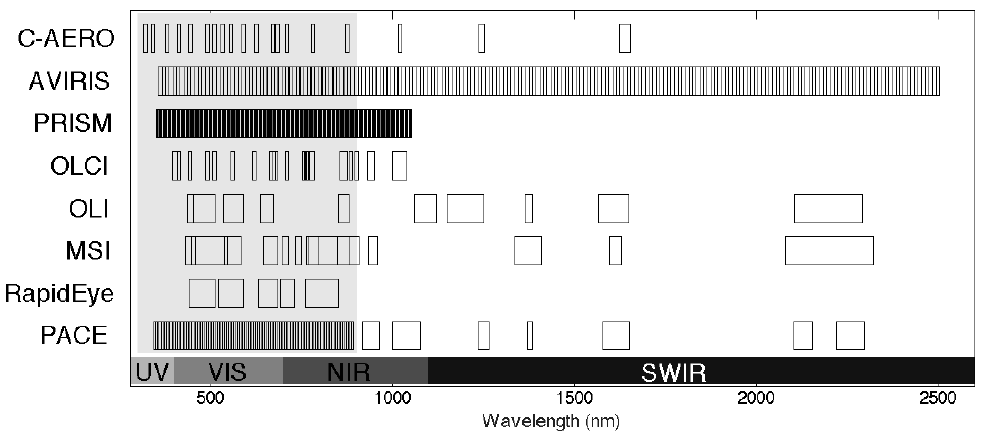
Figure 1. Airborne and satellite sensors considered for simulating H4 sensing, showing band placement and bandwidth. This analysis focuses primarily on the visible (VIS) and near-infrared (NIR) from 400–850 nm, while next-generation sensors such as PACE will extend into the ultraviolet (UV) and most sensors include short wave infrared (SWIR) for atmospheric correction.